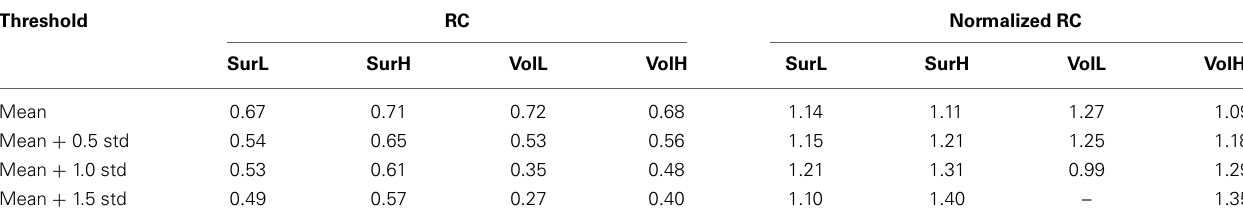
Table 4 | RC and normalized RC of the WM backbone networks under a range of thresholds. Threshold